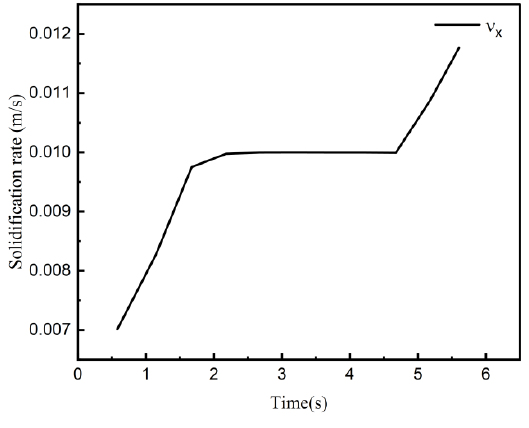
Figure 5. Solidification rate curve.